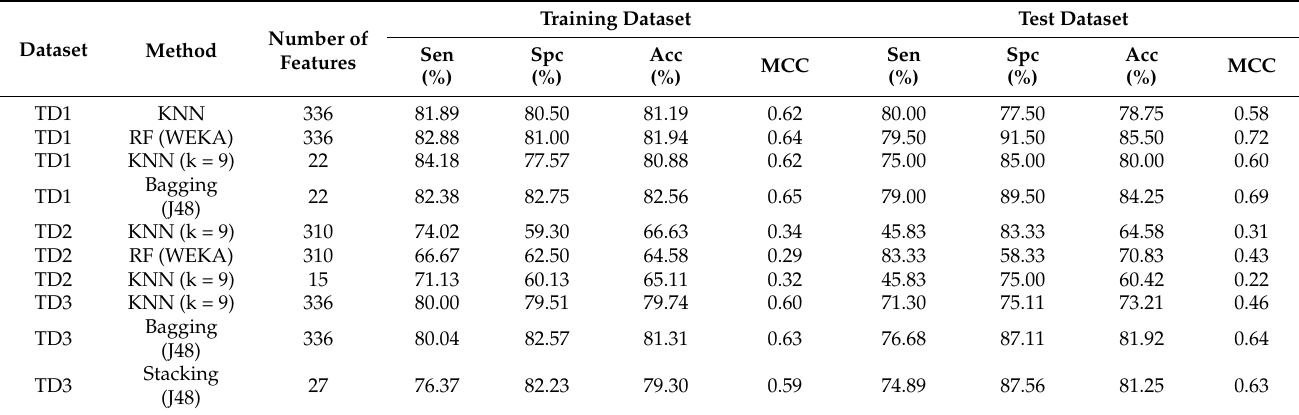
Table 4. In the toxic peptide dataset TD1, TD2 and TD3, the better performance model was established according to different algorithms and different